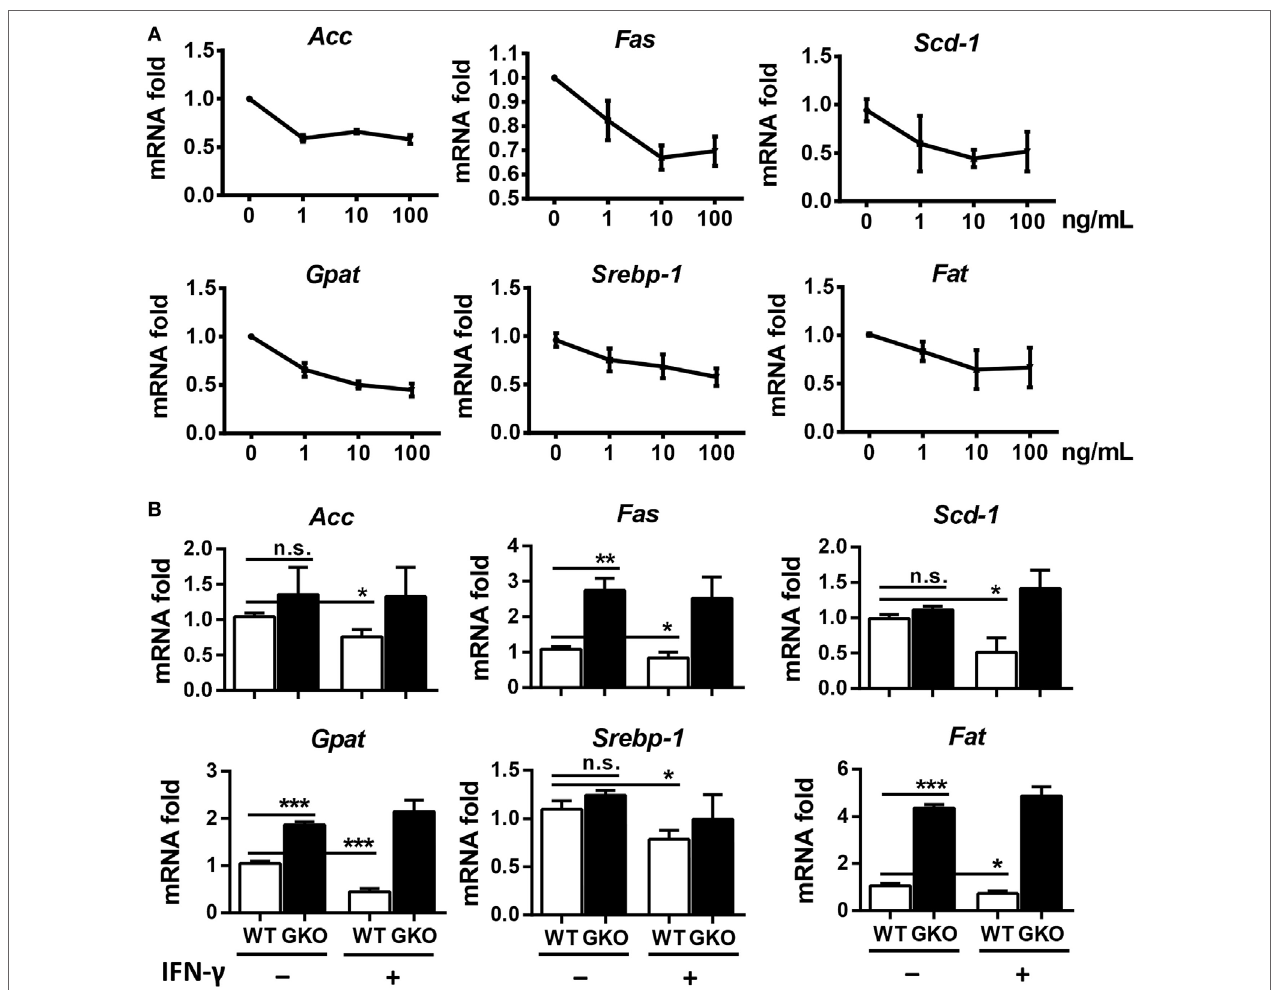
FigUre 4 | Interferon- γ (IFN- γ ) inhibits the expression of fat synthesis-associated genes in hepatocytes. (a) Primary hepatocytes (2 × 10 5 ) from the livers of wild-type (WT) mice were isolated and stimulated with 0, 1, 10, or 100 ng/mL IFN- γ , and the cells were collected to evaluate the mRNA levels of ACC , FAS , SCD-1 , GPAT , SREBP-1 , and FAT after 12 h culture. (B) Primary hepatocytes (2 × 10 5 ) from the livers of WT mice and GKO mice were isolated and stimulated with or without 100 ng/mL IFN- γ , and the cells were collected to evaluate the mRNA levels of ACC , FAS , SCD-1 , GPAT , SREBP-1 , and FAT after 12 h culture. The data are representative of two independent experiments and are shown as the mean ± SEM ( n = 3). * P < 0.05; ** P < 0.01; *** P <